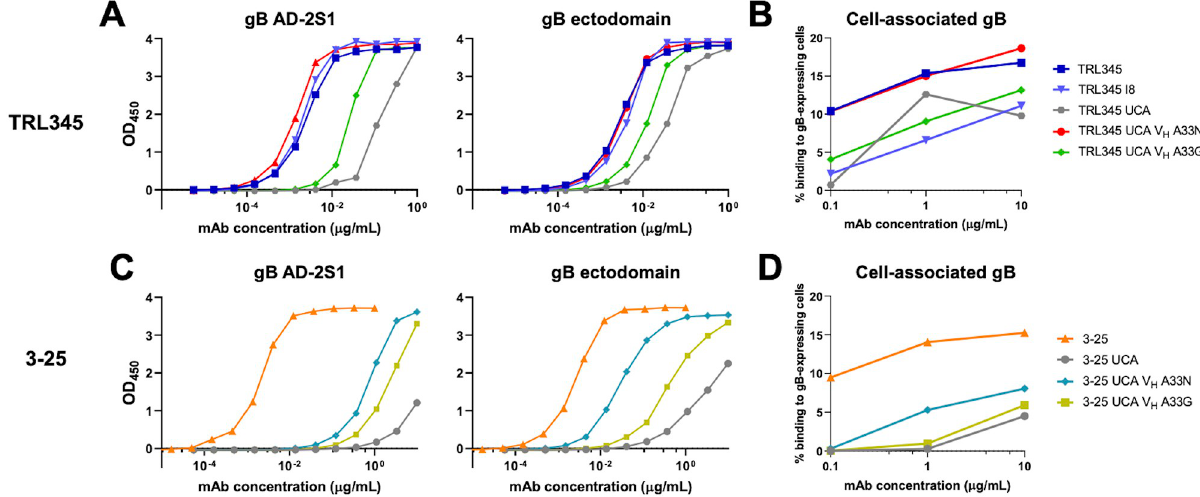
Fig 4. Introduction of V H A33N, as compared with V H A33G, conferred higher binding to gB AD-2S1, gB ectodomain, and cell-associated gB for both the TRL345 UCA and 3–25 UCA antibodies. We produced 4 mutant mAbs wherein we introduced V H A33N or A33G mutations, numbered according to the Kabat scheme, to the TRL345 UCA V H or 3–25 UCA V H and measured the following: (A). Binding magnitude of TRL345 mutant mAbs to gB AD-2S1 peptide and gB ectodomain by ELISA. (B). Binding of TRL345 mutant mAbs to cell-associated gB. Binding of mAbs was determined by coincubating mAbs in a serial dilution with HEK293T epithelial cells-transfected with full-length gB and GFP. The % binding was calculated as the % of GFP-expressing cells bound by the anti-gB AD-2 mAb, detected by flow cytometry. (C). Binding magnitude of 3–25 mutant mAbs to gB AD-2S1 peptide and gB ectodomain by ELISA. (D). Binding to 3–25 mutant mAbs to cell-associated